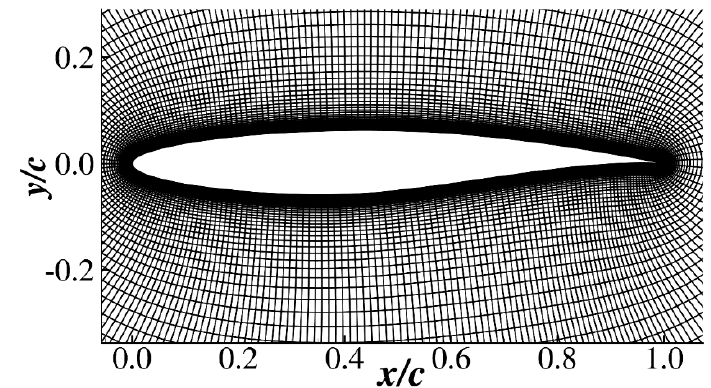
Figure 1. Computational grid of the RAE2822 airfoil (257 × 129 points).